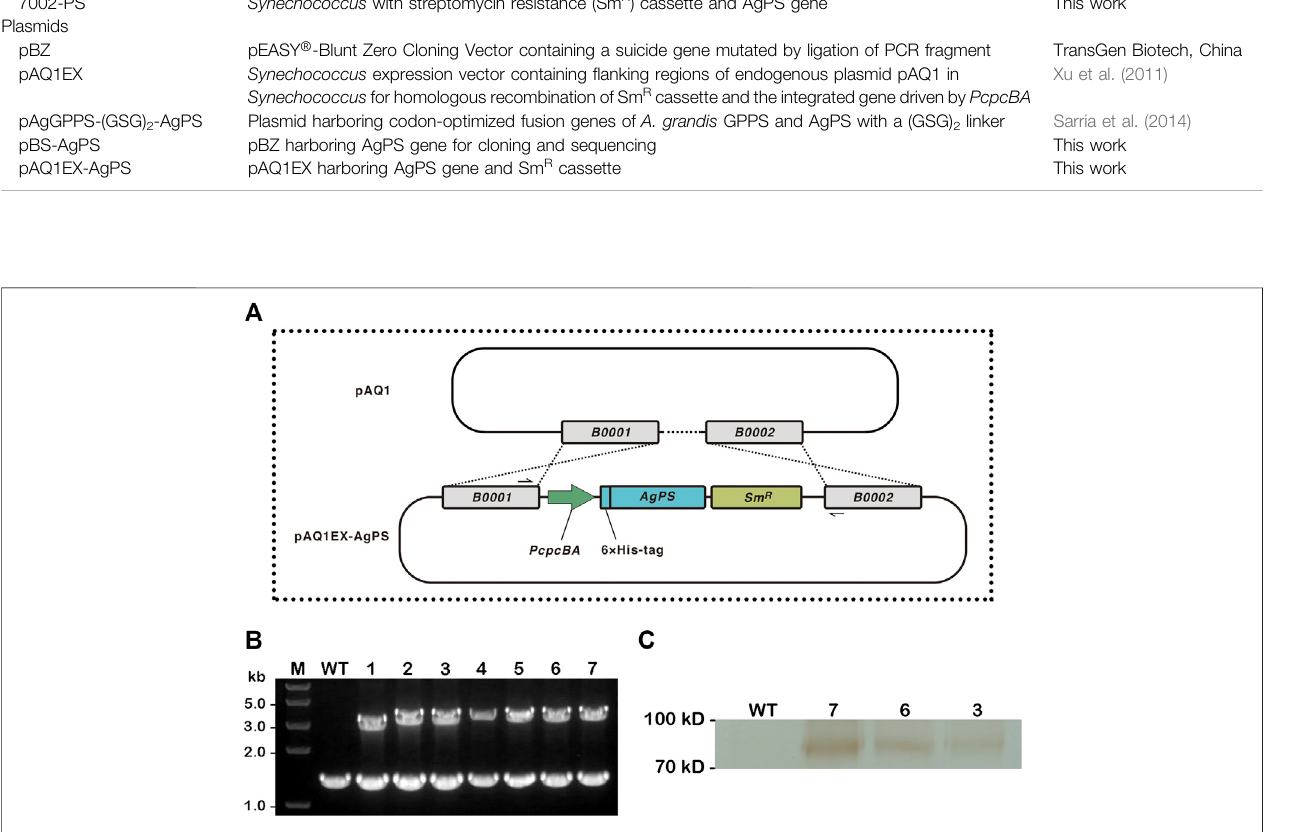
FIGURE 1 | Construction of Synechococcus sp. PCC 7002 overexpressing Abies grandis pinene synthase. (A) Illustrations of the integration of endogenous plasmid pAQ1 in wild-type Synechococcus with the inserted A. grandis pinene synthase (AgPS) cassette in the recombinant plasmid pAQ1EX-AgPS. The AgPS cassette contained PcpcBA to drive transgene expression, and a spectinomycin resistance (Sm R ) selectable marker. The speci fi c primers PAQIN_F and PAQIN_R shown in black solid half arrows are used for demonstrating the successful integration of AgPS cassette into pAQ1 (between open-reading frames B0001 and B0002 ) via double homologous recombination. (B) Con fi rmation of transgene integration by colony PCR using the above-mentioned primers. The wild-type (WT) strain and seven independent transformants of the 7002-PS strain (1 – 7) were veri fi ed. Lane M: Trans 2K ® Plus II DNA Marker (TransGen Biotech, China). Each number above the image of the agarose gel correlated with PCR product. (C) Western blotting analysis of the total protein extract isolated from WT and three independent transformants of the 7002-PS strain (3, 6, and 7). Sample from the WT strain was used as a control. Proteins were detected using anti-His mouse monoclonal antibody (TransGen Biotech, China) followed by the incubation with anti-mouse secondary antibody conjugated with HRP. Reactions were visualized using a DAB horseradish peroxidase color development kit (Beyotime,